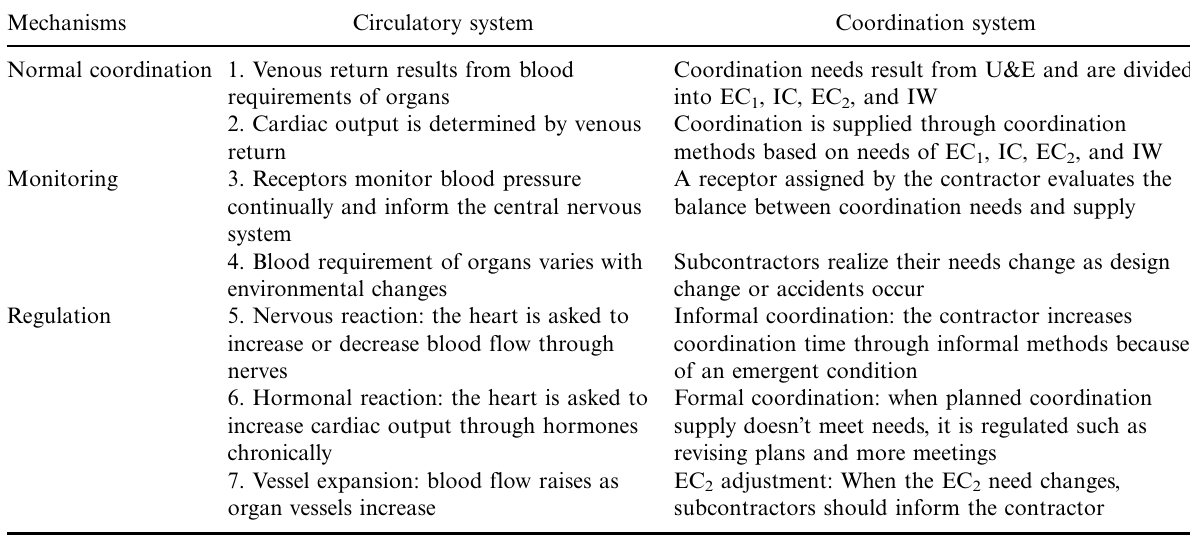
Table 2. Operation comparisons of coordination system and circulatory system Mechanisms Circulatory system Coordination system Normal coordination 1. Venous return results from blood requirements of organs